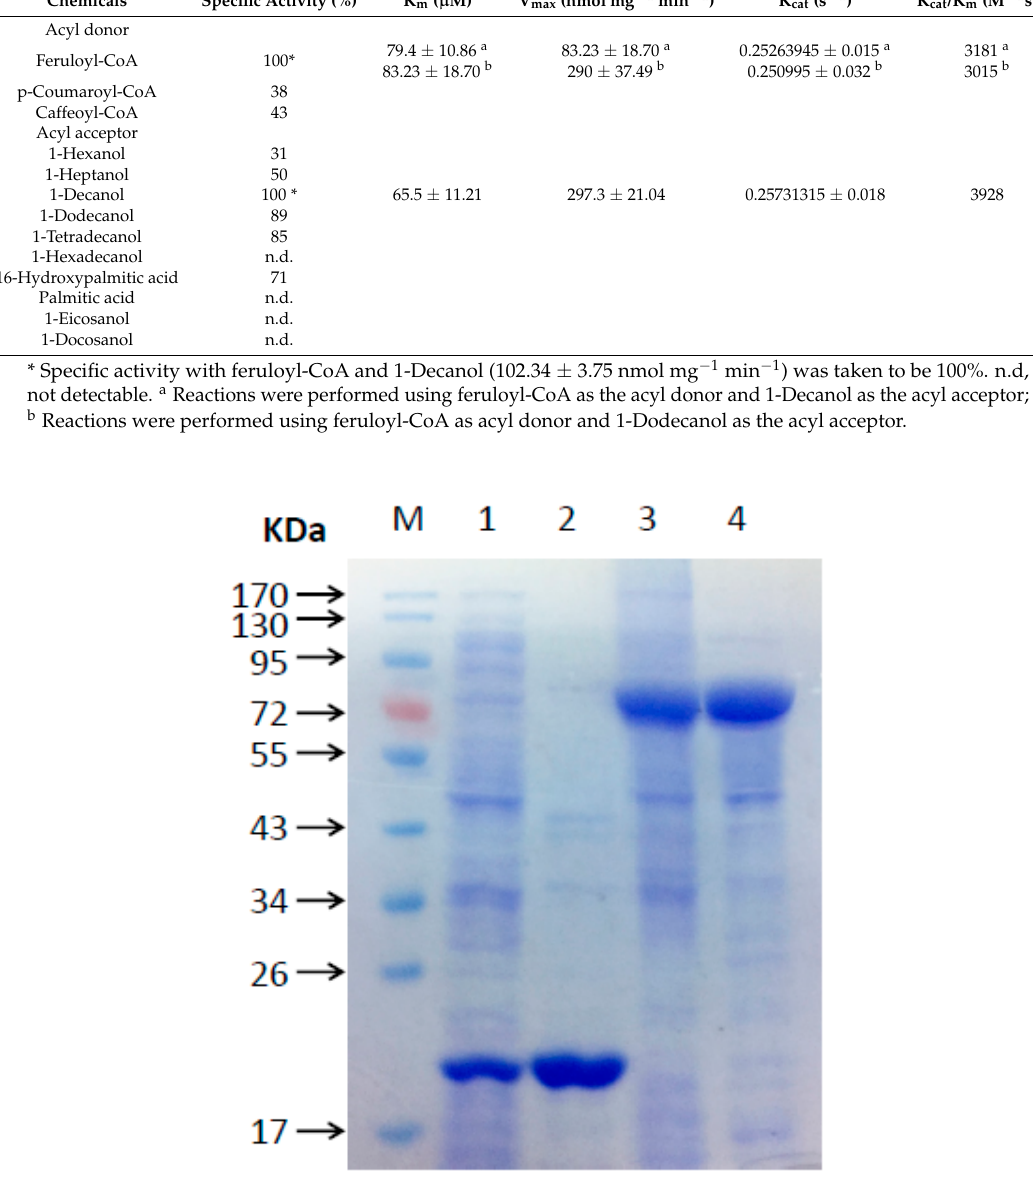
Figure 3. SDS-PAGE separation of recombinant MeHFT. Lane M: molecular mass standards. Lane 1: culture medium from E coli cells harboring an empty pET32a vector control; lane 2: proteins purified from the culture medium used in lane 1; lane 3: culture medium from E coli cells harboring pET32a-MeHFT; lane 4: proteins purified from the culture medium used in lane 3.